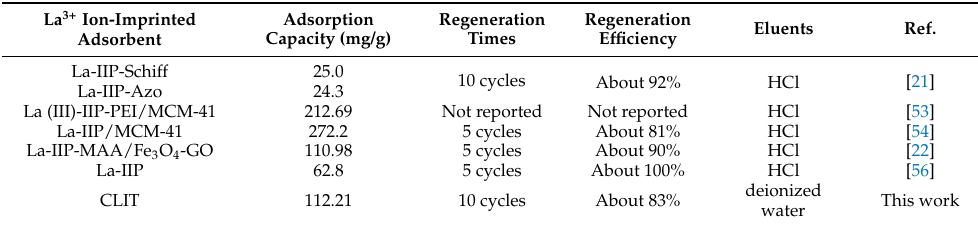
Table 4. Adsorption capacity and regeneration performance of La 3+ ion-imprinted adsorbents. La 3+ Ion-Imprinted